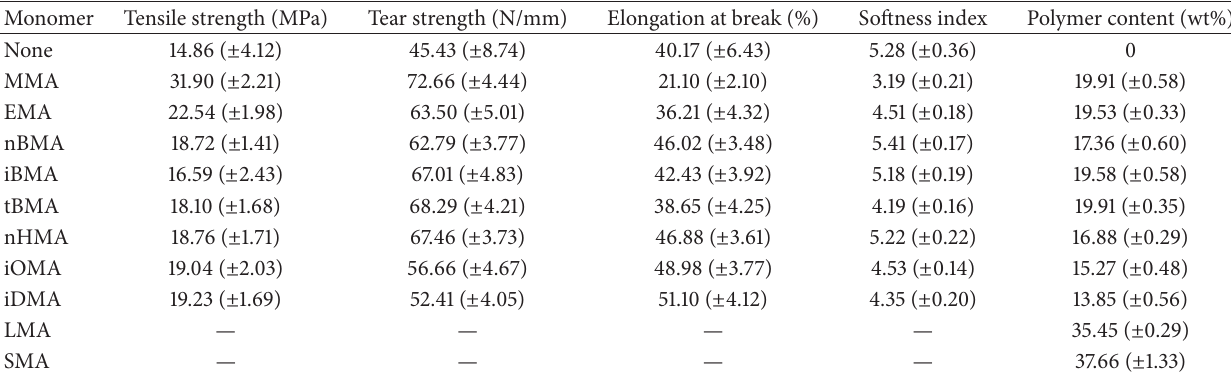
Table 2: Physical properties and polymer contents of the PMA/leather split